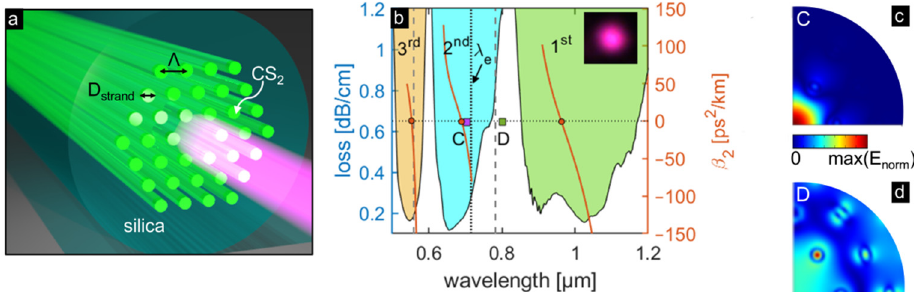
Figure 1. ( a ) Sketch of the CS 2 - photonic bandgap fiber (PBGF) (green: hexagonal array of high-index CS 2 strands with diameter D strand = 1.44 μ m and pitch Λ = 3.6 μ m; semitransparent dark green: silica; pink: light emitted from the silica core); ( b ) measured loss spectrum of the fundamental mode (filled areas with green, cyan and yellow colors, left axis) and the corresponding simulated group velocity dispersion (GVD) parameter β 2 (orange, right axis). The orange dots indicate three zero dispersion wavelengths (ZDWs). The two grey dashed vertical lines indicate the calculated resonance wavelengths from Equation (1) with m = 2 and 3. The black dotted line indicates the bandgap edge ( − 5 dB) at 715 nm of the second order PBG. The inset in ( b ) is the output beam profile captured by the CCD camera (image extension 265 µ m: 50 pixels with each pixel size 5.3 µ m). The mode field patterns shown in ( c , d ) refer to the simulated mode profiles inside a selected transmission band (( c ) λ = 700 nm, purple square in ( b ) labeled C) and inside a resonance region (( d ) λ = 800 nm, green square in ( b ) labeled D).